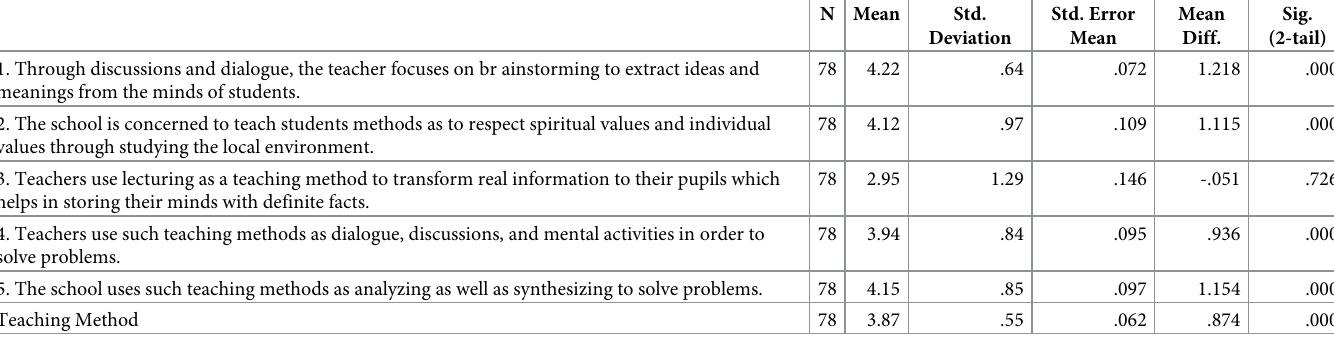
Table 8. One-sample statistics (teaching methods and related items, test value = 3).